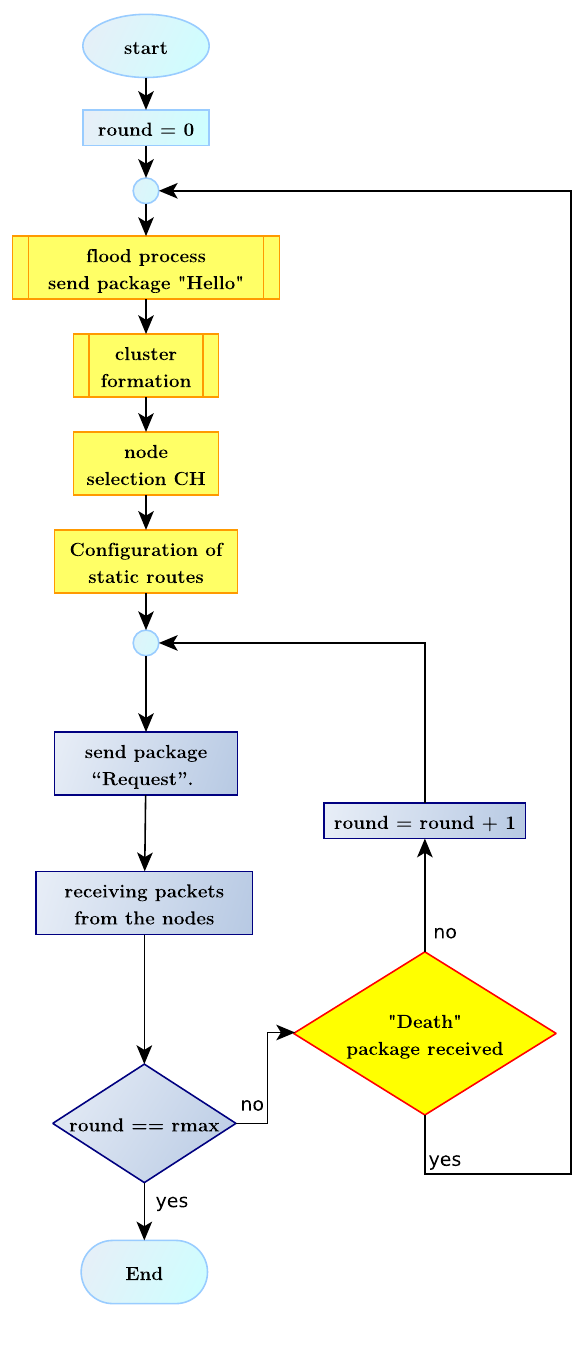
Figure 9. Routing flowchart H-kdtree